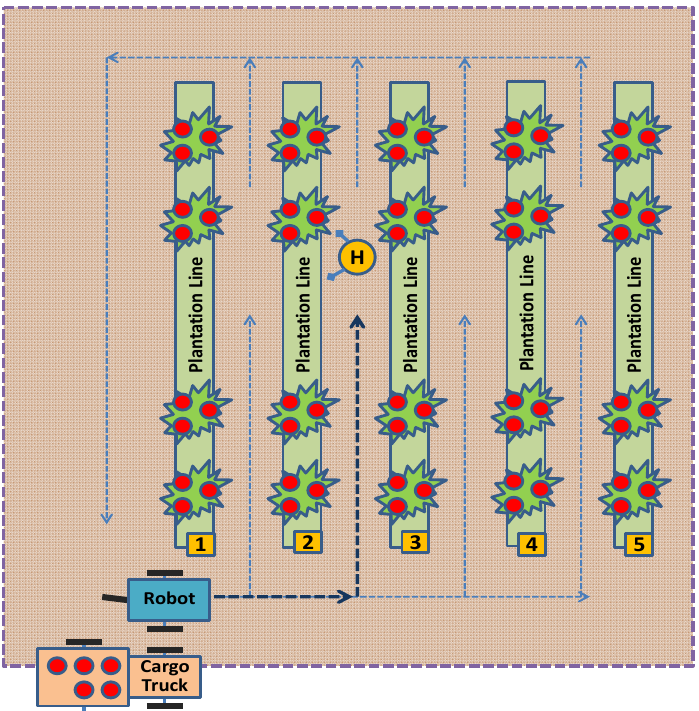
Figure 1. A typical arrangement for all the components being necessary for the fruit transport pro- cess.